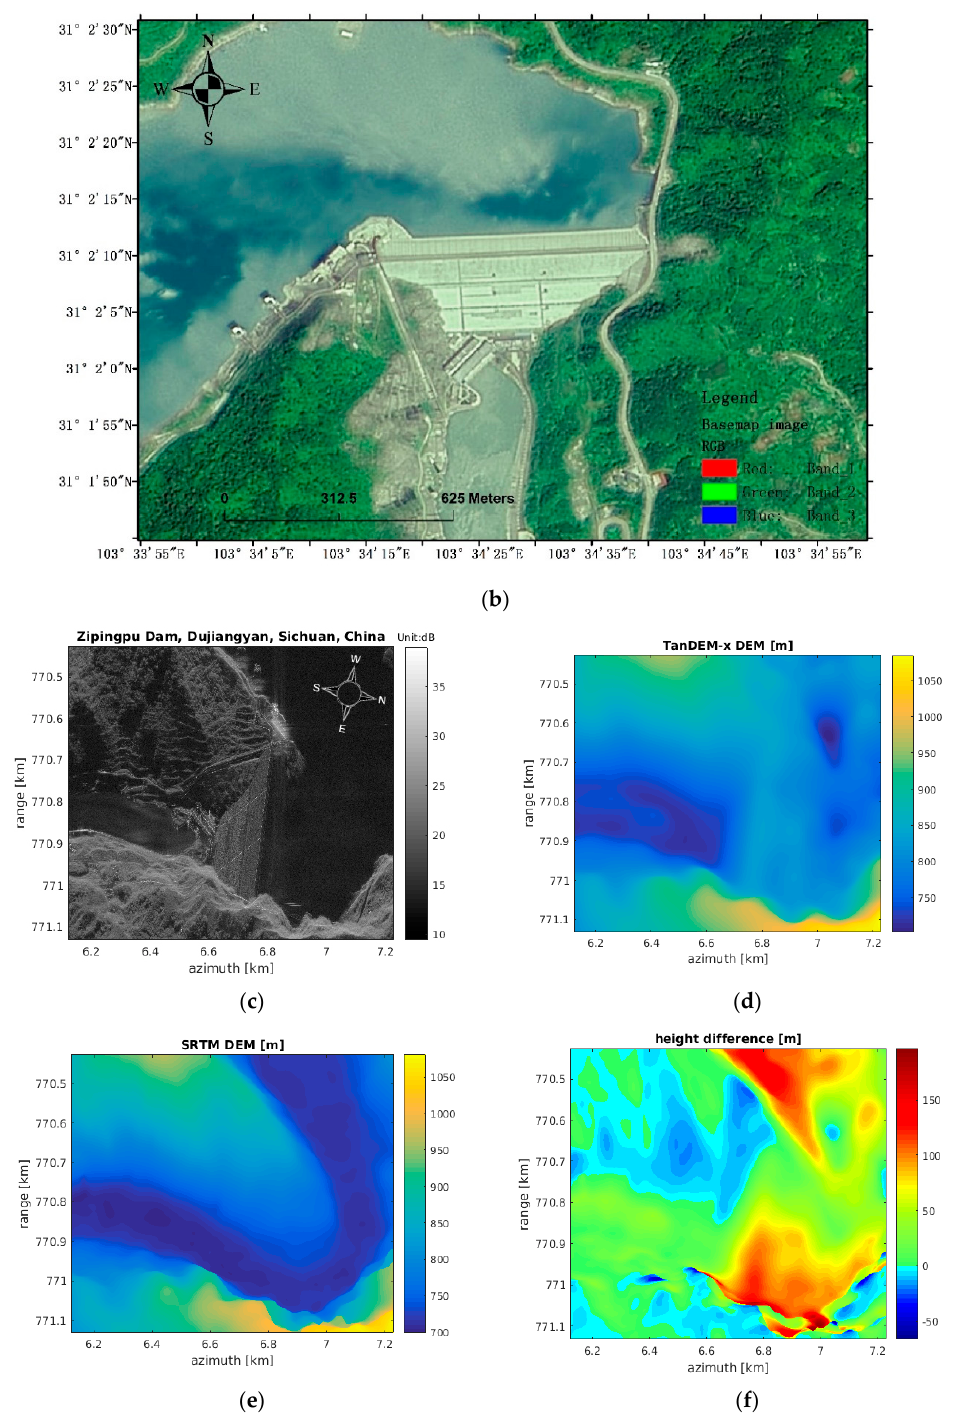
Figure 8. The test site and a small test subarea at Zipingpu Dam in Dujiangyan, Sichuan, China (master image is 25/07/2016). ( a ) The test site in Sichuan China, the red area is COSMO-SkyMed Spotlight data stacks, the background image is a Google Earth image (image source: Landsat im- age/Copernicus). ( b ) Overview of Zipingpu Dam (Source: Tianditu, China). ( c ) SAR image of the test subarea, the color of the figure is the average amplitude of all SAR SLC stacks, the unit is dB. ( d ) Azimuth test line on TanDEM. ( e ) Azimuth test line on the SRTM 30 m data. ( f ) The azimuth test line of the height difference between the TanDEM-X DEM 12 m DEM and SRTM 30 m